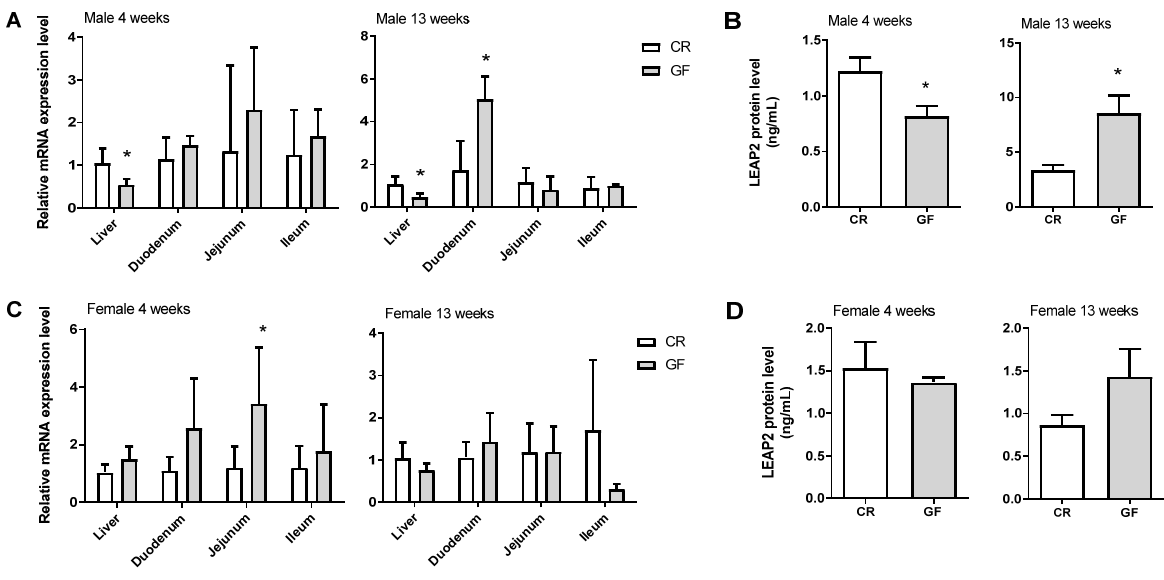
Figure 1. Leap2 expression in germ-free mice. Gene expression of Leap2 was measured in the liver and small intestinal regions of conventionally raised (CR) and germ-free (GF) male mice at 4 and 13 ( A ) weeks of age by qPCR and plotted relative to CR mice for each age and each tissue. LEAP2 protein levels (ng/mL) were measured in the plasma of CR and GF male mice at 4 and 13 ( B ) weeks of age by ELISA and represented as means ± S.D. n = 5–6. * p ≤ 0.05. Gene expression of Leap2 was measured in the liver and small intestinal regions of conventionally raised (CR) and germ-free (GF) female mice at 4 and 13 ( C ) weeks of age by qPCR and plotted relative to CR mice for each age and each tissue. LEAP2 protein levels (ng/mL) were measured in the plasma of CR and GF female mice at 4 and 13 ( D ) weeks of age by ELISA and represented as means ± S.D. n = 5–6. * p ≤ 0.05.